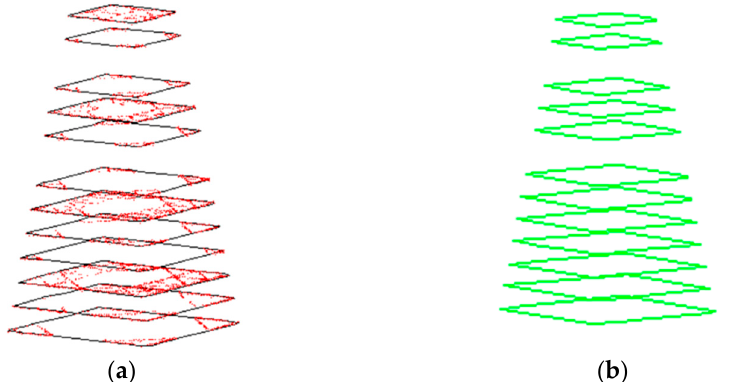
Figure 8. Feature plane contours analysis, ( a ) original feature planes; ( b ) simplified feature planes.